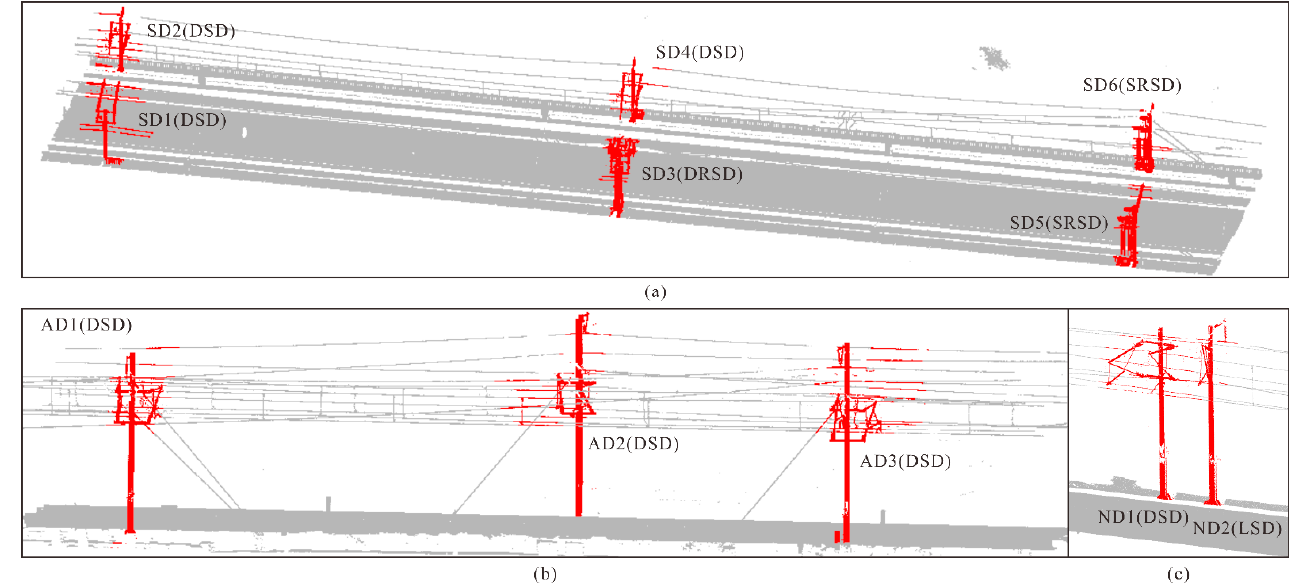
Figure 8. Display diagram of the three types of distribution of support device scenes: ( a ) the SD, ( b ) the AD, and ( c ) the ND.